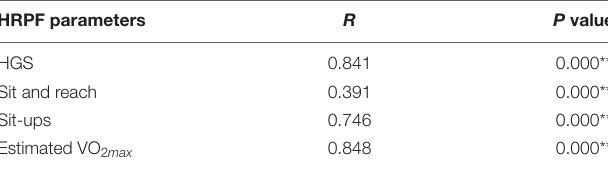
TABLE 6 | Relationship between measured and predicted HRPF